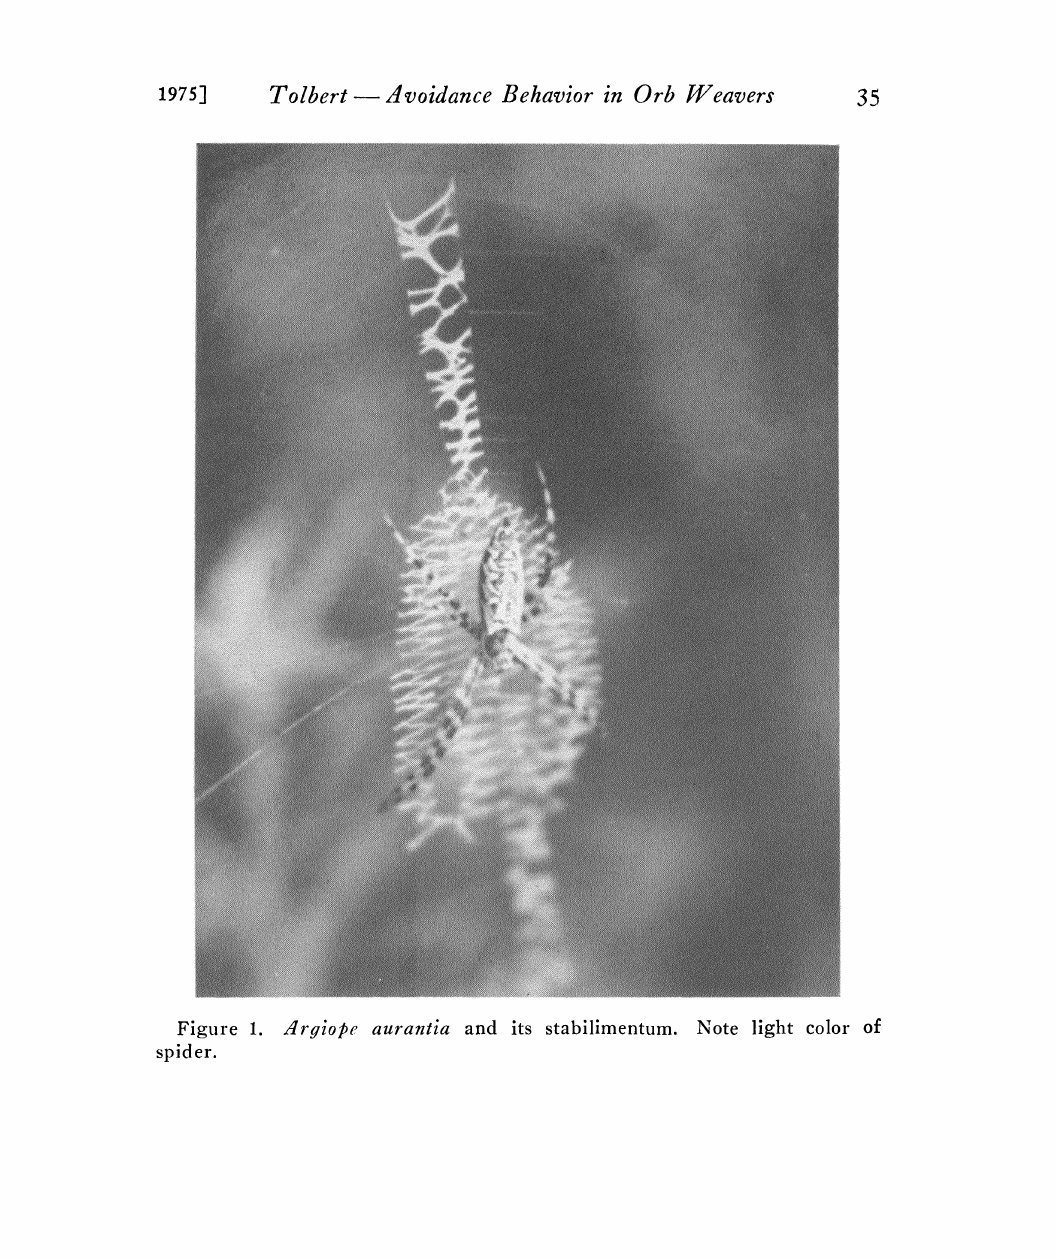
Figure 1. drgiope aurantia and its stabilimentum. Note light color of